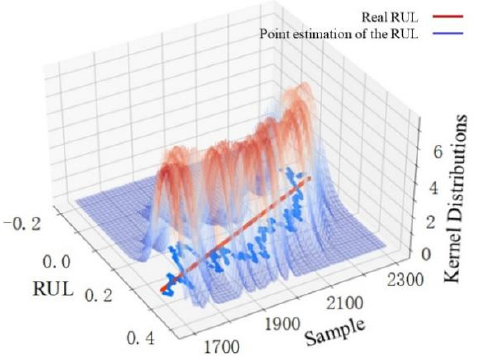
Figure 10. RUL point estimation and nonparametric kernel density distribution in the second stage.